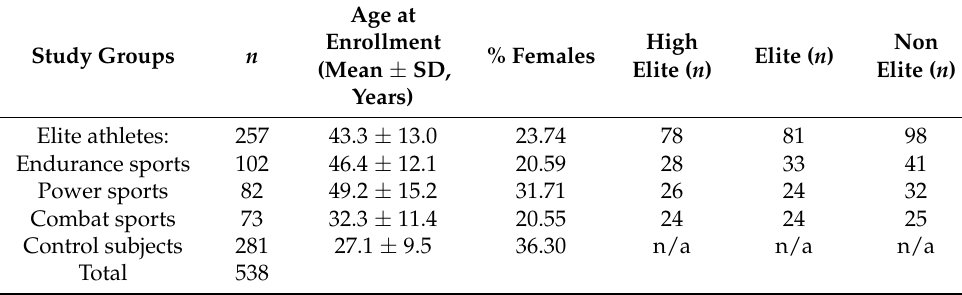
Table 2. Validation group